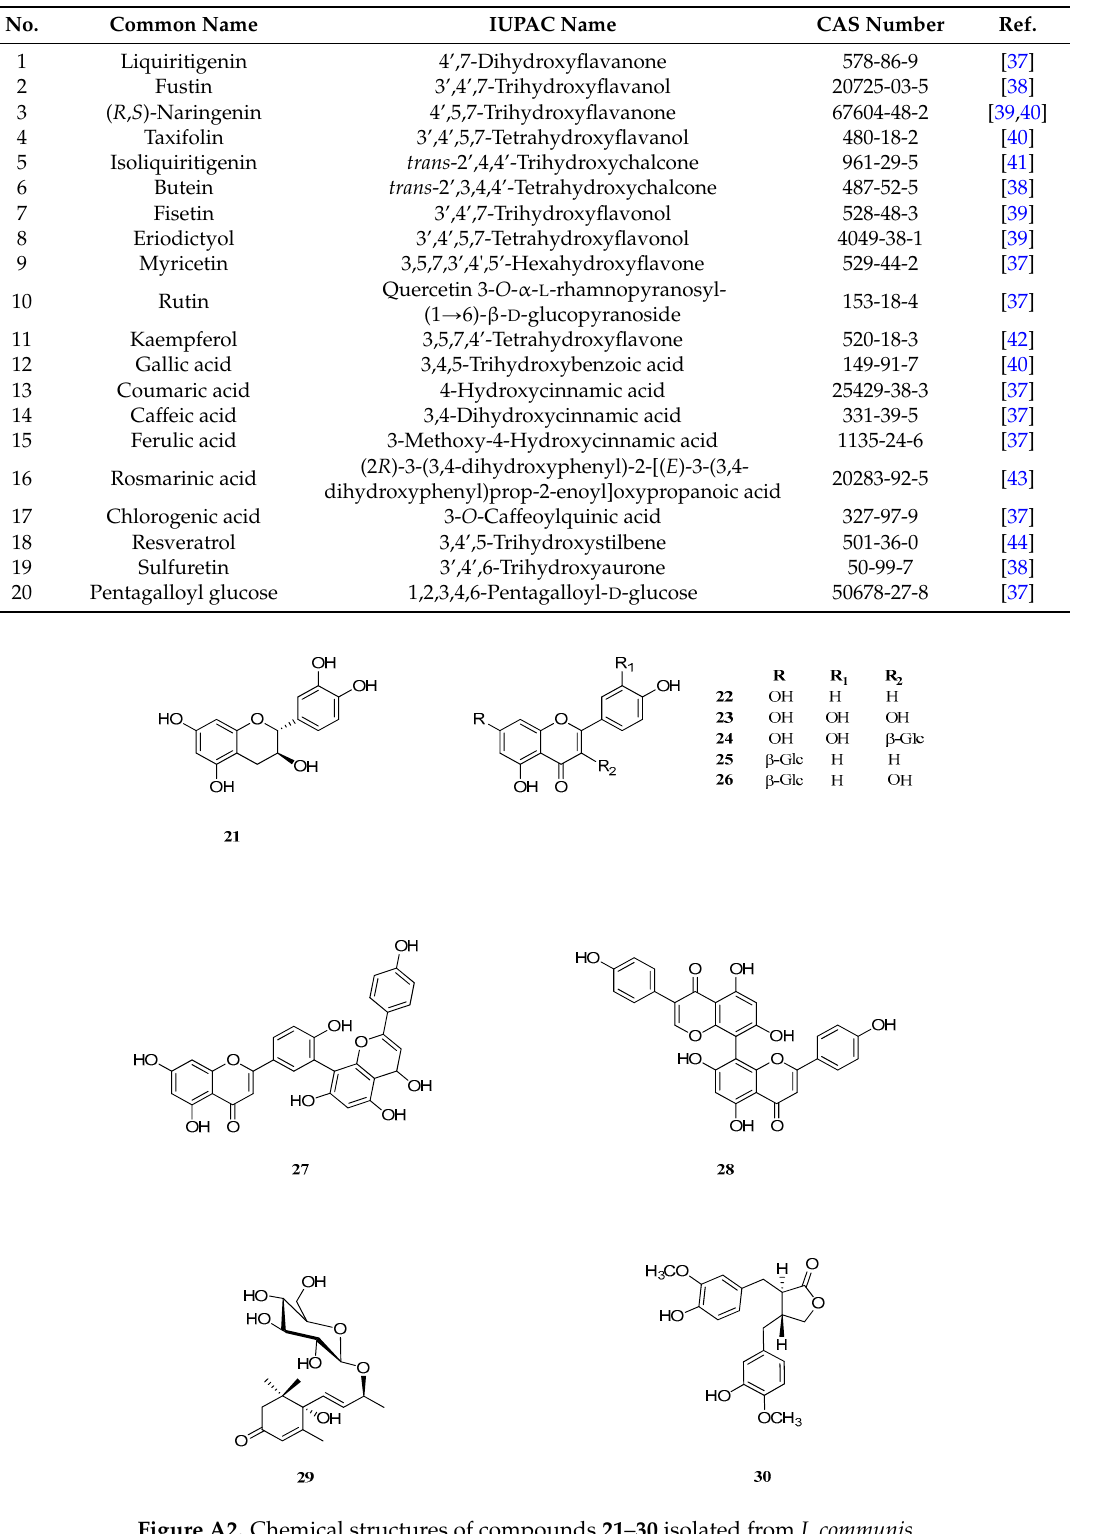
Table A1. Compounds 1 – 20 identified by methanol extract of C. coggygria .